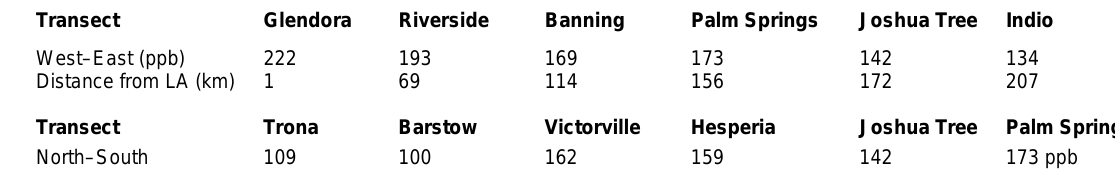
Comparison of Maximum Seasonal Ozone at Other Monitoring Stations in